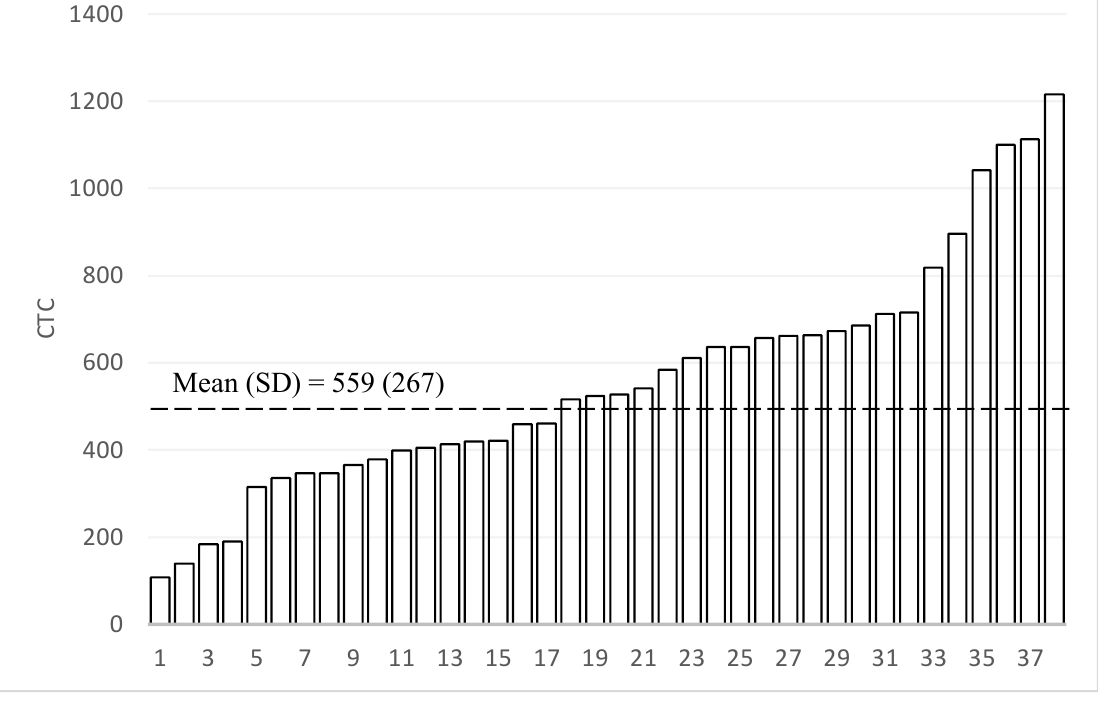
Figure 3. Distribution of Conversational Turn Count (CTC, N = 38). “SD” is defined as standard deviation.